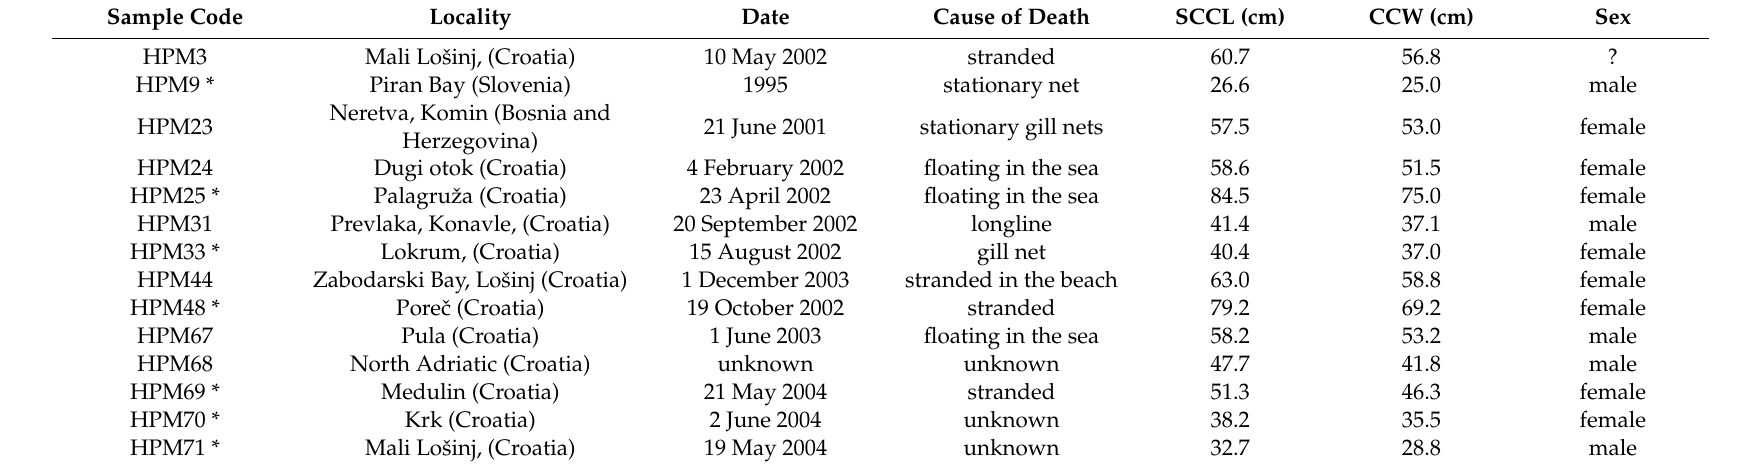
Table 1. Turtle sample code, locality and date of the carcass finding, cause of death, carapace size (SCCL—standard curved carapace length, CCW—curved carapace width) and sex of the sampled